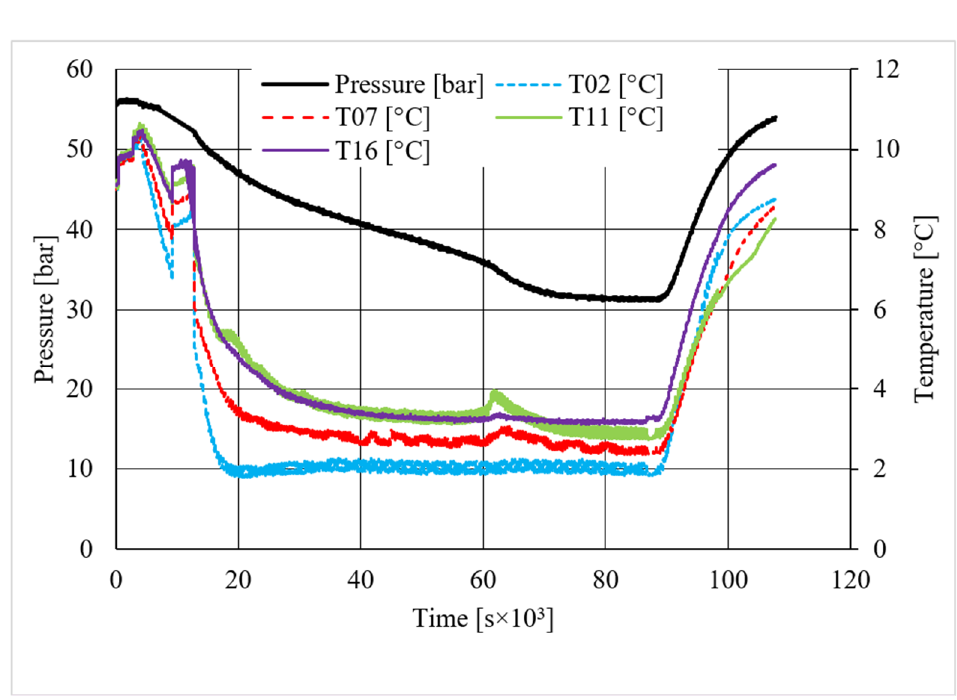
Figure 5. Pressure and temperature trends over time, measured for methane hydrate formation in the absence of CuSn12 powder.